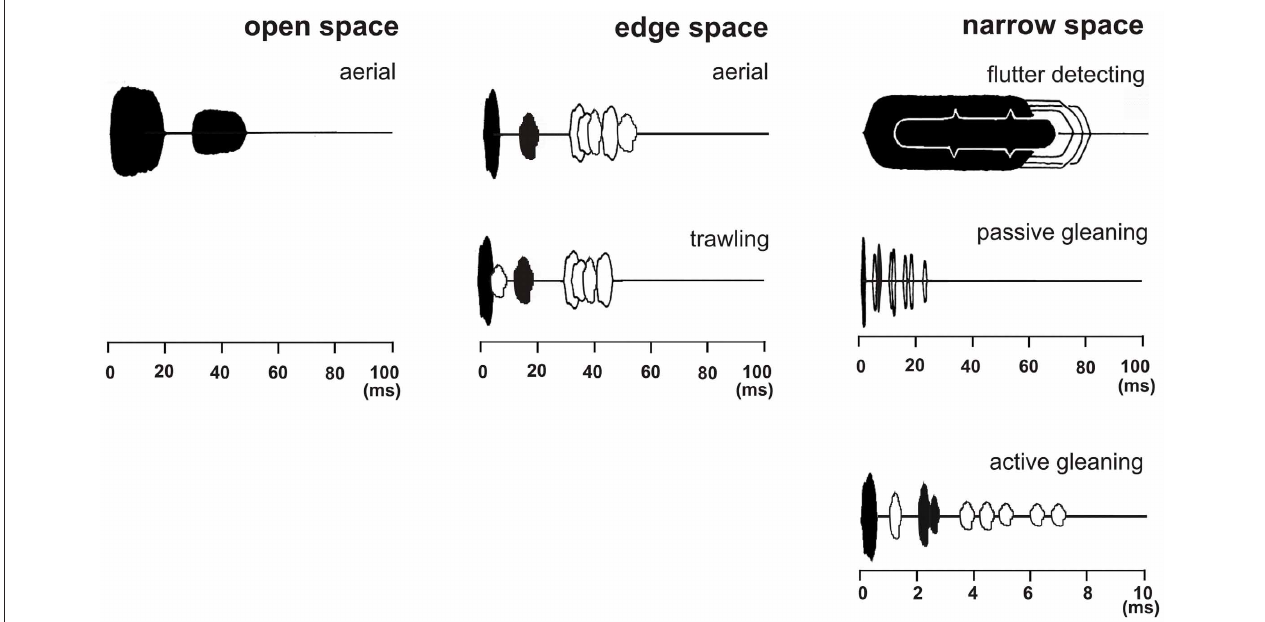
FIGURE 2 | Echolocation scenes of bats that search for prey in three different foraging habitats with typical foraging modes. The emitted signal (black) and the returning echoes from prey (black) are displayed together with echo trains from background targets (white). In the depicted echolocation scene which covers a time range of 100ms a bat foraging in open space in the aerial mode perceives a pulse-echo pair consisting only of the emitted signal and the returning echo (both in black) as long as the background is further away than 17m. Bats foraging in edge space in the aerial mode perceive a pulse-echo pair that is followed by clutter echoes from the background (in white). When foraging in the trawling mode above the water an additional surface echo returns